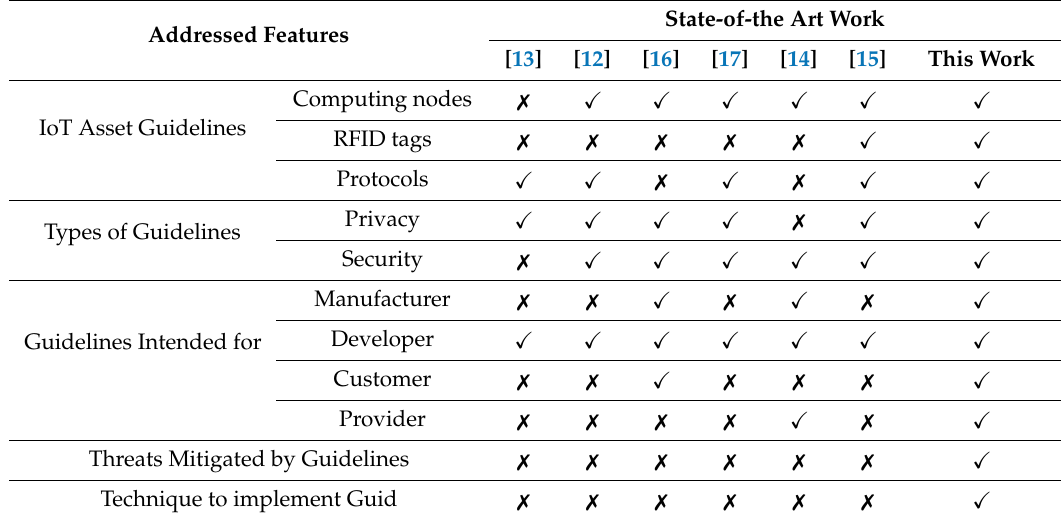
Table 1. Comparison of research e ff orts presented in the literature. Table 1. Comparison of research efforts presented in the literature. Table 1. Comparison of research efforts presented in the literature. Table 1. Comparison of research efforts presented in the literature. Table 1. Comparison of research efforts presented in the literature. Table 1. Comparison of research efforts presented in the literature. Table 1. Comparison of research efforts presented in the literature. Table 1. Comparison of research efforts presented in the literature. Table 1. Comparison of research efforts presented in the literature. Table 1. Comparison of research efforts presented in the literature. Table 1. Comparison of research efforts presented in the literature. Table 1. Comparison of research efforts presented in the literature. Table 1. Comparison of research efforts presented in the literature. Table 1. Comparison of research efforts presented in the literature. Table 1. Comparison of research efforts presented in the literature. Table 1. Comparison of research efforts presented in the literature. Table 1. Comparison of research efforts presented in the literature. Table 1. Comparison of research efforts presented in the literature. Table 1. Comparison of research efforts presented in the literature. Table 1. Comparison of research efforts presented in the literature. Table 1. Comparison of research efforts presented in the literature. Table 1. Comparison of research efforts presented in the literature. Table 1. Comparison of research efforts presented in the literature. Table 1. Comparison of research efforts presented in the literature. Table 1. Comparison of research efforts presented in the literature. Table 1. Comparison of research efforts presented in the literature. Table 1. Comparison of research efforts presented in the literature. Table 1. Comparison of research efforts presented in the literature. Table 1. Comparison of research efforts presented in the literature. Addressed Features Table 1. Comparison of research efforts presented in the literature. Table 1. Comparison of research efforts presented in the literature. Table 1. Comparison of research efforts presented in the literature. Table 1. Comparison of research efforts presented in the literature. Table 1. Comparison of research efforts presented in the literature. Table 1. Comparison of research efforts presented in the literature. Table 1. Comparison of research efforts presented in the literature. Addressed Features Addressed Features Table 1. Comparison of research efforts presented in the literature. Table 1. Comparison of research efforts presented in the literature. Table 1. Comparison of research efforts presented in the literature. Table 1. Comparison of research efforts presented in the literature. Table 1. Comparison of research efforts presented in the literature. Table 1. Comparison of research efforts presented in the literature. Table 1. Comparison of research efforts presented in the literature. Addressed Features Table 1. Comparison of research efforts presented in the literature. Table 1. Comparison of research efforts presented in the literature. Table 1. Comparison of research efforts presented in the literature. Table 1. Comparison of research efforts presented in the literature. Table 1. Comparison of research efforts presented in the literature. Table 1. Comparison of research efforts presented in the literature. Table 1. Comparison of research efforts presented in the literature. Addressed Features Table 1. Comparison of research efforts presented in the literature. Table 1. Comparison of research efforts presented in the literature. Table 1. Comparison of research efforts presented in the literature. Table 1. Comparison of research efforts presented in the literature. Table 1. Comparison of research efforts presented in the literature. Table 1. Comparison of research efforts presented in the literature. Table 1. Comparison of research efforts presented in the literature. Table 1. Comparison of research efforts presented in the literature. Table 1. Comparison of research efforts presented in the literature. Table 1. Comparison of research efforts presented in the literature. Table 1. Comparison of research efforts presented in the literature. Table 1. Comparison of research efforts presented in the literature. Table 1. Comparison of research efforts presented in the literature. Table 1. Comparison of research efforts presented in the literature. Table 1. Comparison of research efforts presented in the literature. Table 1. Comparison of research efforts presented in the literature. Table 1. Comparison of research efforts presented in the literature. Table 1. Comparison of research efforts presented in the literature. Table 1. Comparison of research efforts presented in the literature. Table 1. Comparison of research efforts presented in the literature. Table 1. Comparison of research efforts presented in the literature. Table 1. Comparison of research efforts presented in the literature. Table 1. Comparison of research efforts presented in the literature. Table 1. Comparison of research efforts presented in the literature. Table 1. Comparison of research efforts presented in the literature. Table 1. Comparison of research efforts presented in the literature. Table 1. Comparison of research efforts presented in the literature. Table 1. Comparison of research efforts presented in the Addressed Features Addressed Features